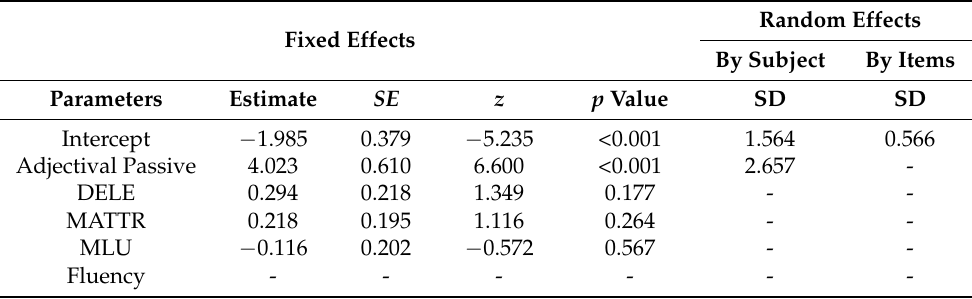
Table 9. Parameter estimates for L2 learners’ comprehension of passives by proficiency.